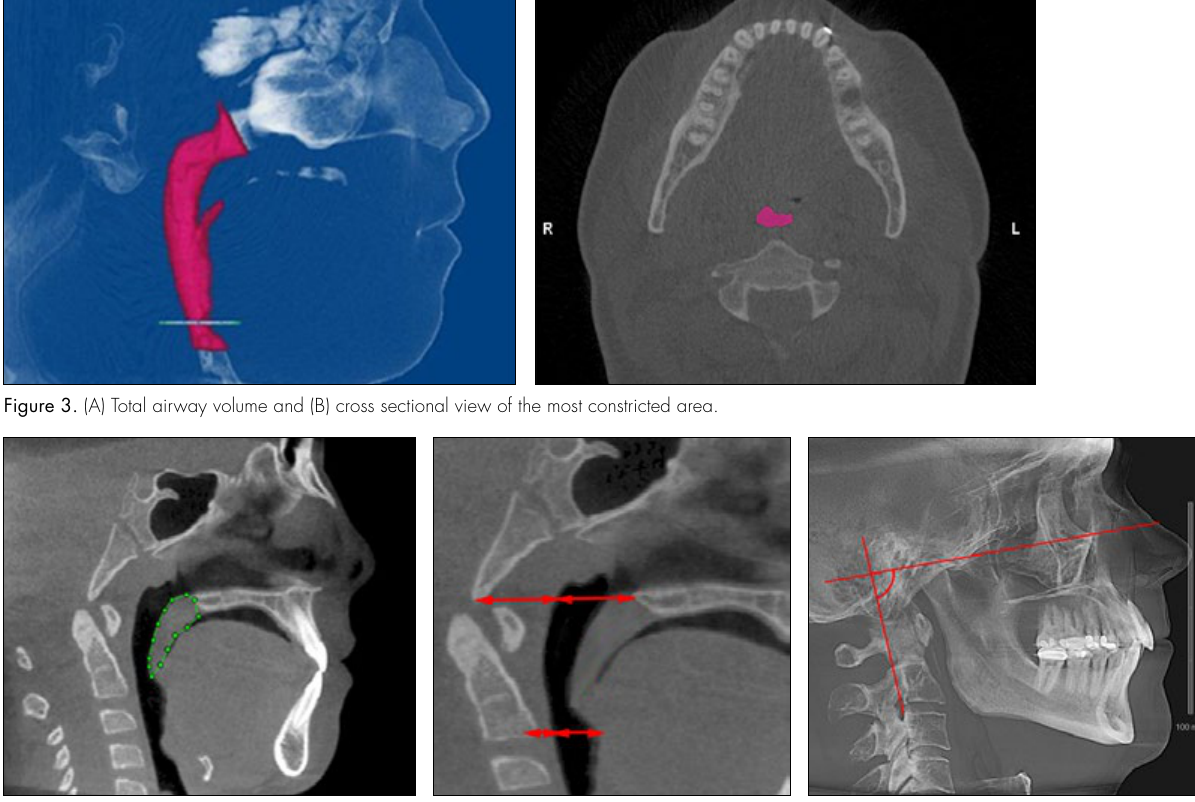
Figure 6. Cervical vertebrae sagittal depth of the airway at the levels of nasopharynx and oropahyrnx.